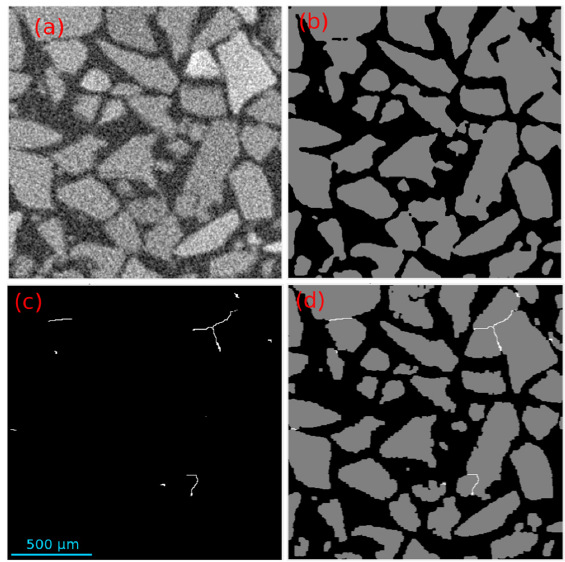
Figure A1. Cross-sections within the 3D reconstructed X-ray tomogram to illustrate the post-treatments performed: ( a ) raw monomodal SAP pileup; ( b ) segmentation and medium filter applied, two phases only viewed: air in pores and SAP; ( c ) watershed applied, contacts between SAP only viewed; ( d ) all phases (pores, SAP and contact between SAP (color code black, gray, white)). Due to these gray level gradients, the segmentation of a phase on a 3D tomogram named thresholding required special care. Thresholding consists of converting a grayscale image into a binary image by defining a grayscale cutoff point. After this step, post-pro- cessing is performed on the binary images to remove noise using a “Median 3D” filter several times. This results in a clear binary section with two well identified phases (Figure A1b). The numerical color code chosen, associates gray with SP, and black with an IP full of air.